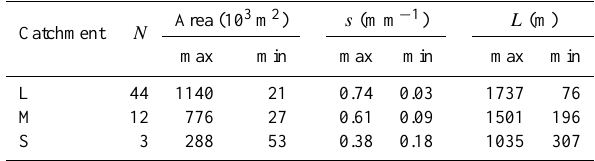
Table 2. Characteristics of GRUs for catchments.